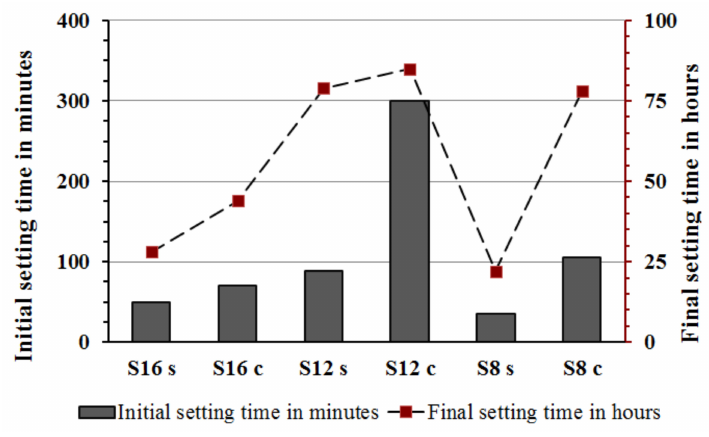
Figure 4. Initial and final setting time results of the AAS pastes.